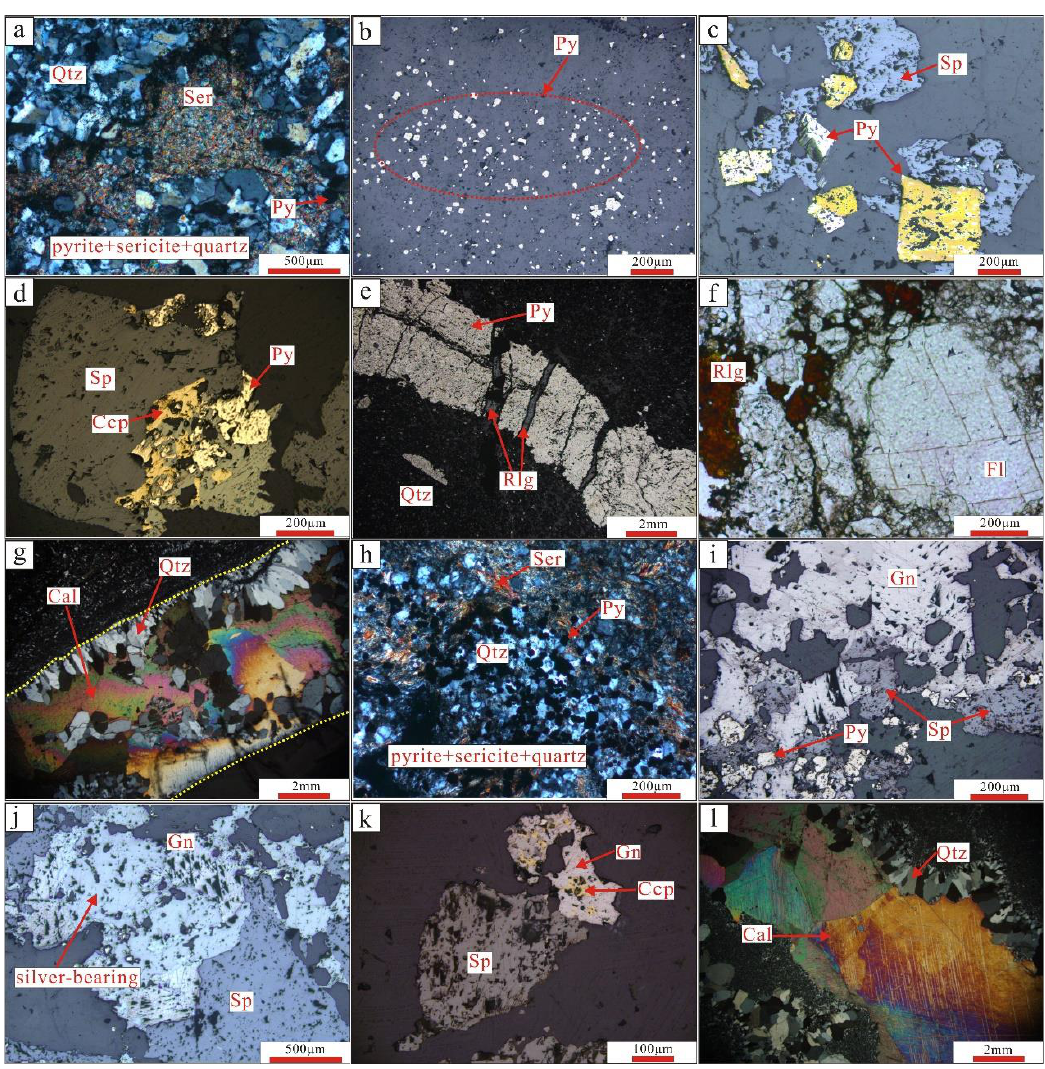
Figure 5. Photomicrographs showing the mineral assemblages and the alteration of different stages in the Changkeng – Fuwan Au ( a – g )-Ag ( h – l ) deposit. ( a , f , g , h , l ) Transmitted light, ( b – e , i – k ) reflected light). ( a ) Early stage pyrite + sericite + silica alteration; ( b ) euhedral to subhedral pyrite; ( c ) middle stage sphalerite; ( d ) galena, sphalerite, and chalcopyrite in the middle stage; ( e ) middle stage pyrite cut by late stage realgar; ( f ) realgar and fluorite in the late stage; ( g ) quartz and calcite vein in the late stage; ( h ) early stage pyrite + sericite + silica alteration; ( i ) middle stage galena and sphalerite replacing pyrite; ( j ) silver-bearing mineral intergrowth with galena and sphalerite in the middle stage; ( k ) galena, sphalerite, and chalcopyrite in the middle stage; and ( l ) quartz and calcite vein in the late stage. Py, pyrite; Gn, galena; Ccp, chalcopyrite; Sp, sphalerite; Qtz, quartz; Ser, sericite; Rlg, realgar; and Cal, calcite.